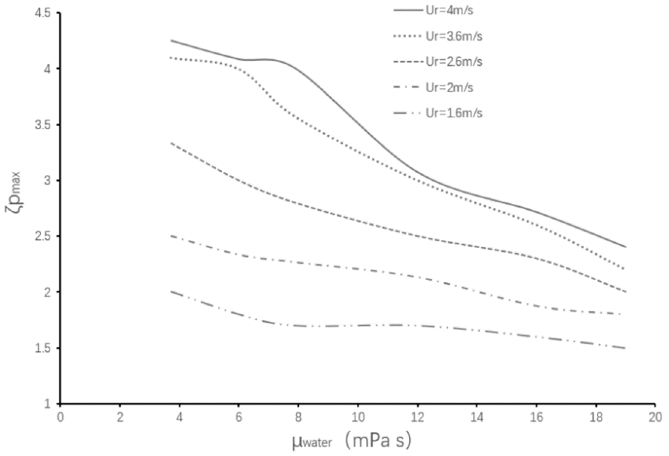
Figure 9. Change in ζ pmax with the aqueous phase’s viscosity and the collision velocity.